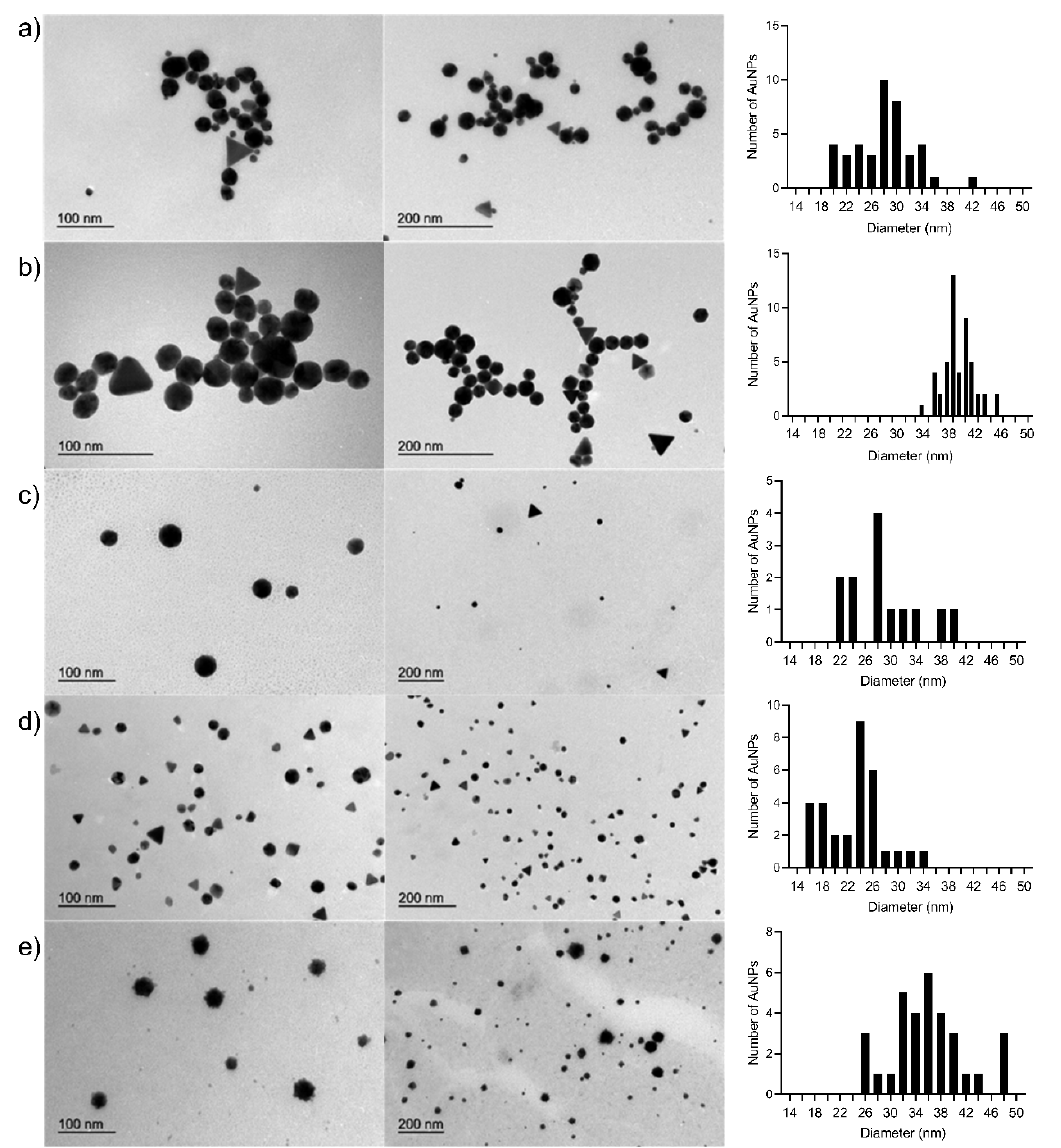
Figure 2. TEM images and size distributions of Cs-AuNPs prepared in experiments ( a ) 3, ( b ) 4, ( c ) 11, ( d ) 12 and ( e ) ( d ) 12 and ( e ) 13.